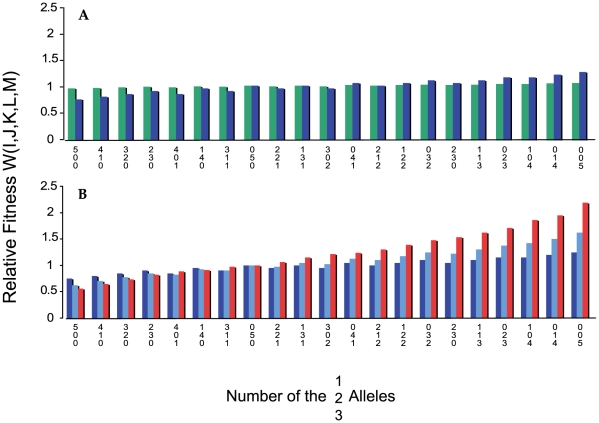
Relative fitness of the different genotypes W(I,J,K,L,M) as a function of the number of 1, 2 and 3 alleles as calculated from equations (1).(A) green: c = 0.9, e = 1.0, blue: c = 0.5, e = 1.0; (B) blue: c = 0.5, e = 1.0, light blue: c = 0.5, e = 2.0, red: c = 0.5, e = 3.0.